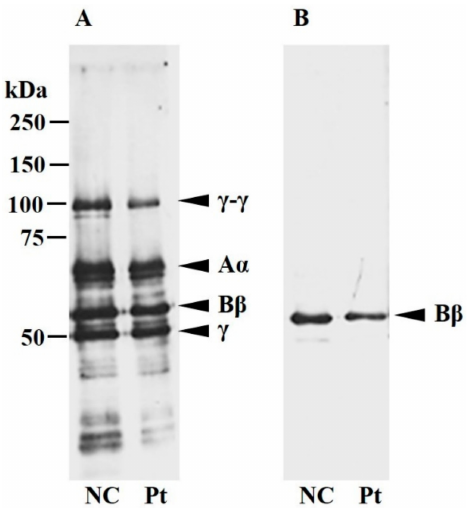
Figure 1. Western blot analysis of plasma fibrinogen. A healthy volunteer’s plasma (NC) and the patient’s plasma (Pt), equivalent to 100 ng fibrinogen, were separated on 10% SDS-PAGE under reducing conditions. Blots were developed with an anti-fibrinogen polyclonal antibody ( A ) or anti-B β -chain polyclonal antibody ( B ) as described in the Materials and Methods section. The bands derived from normal fibrinogen are indicated as γ - γ -, A α -, B β -, and γ -chains, and the patient band pattern corresponded to